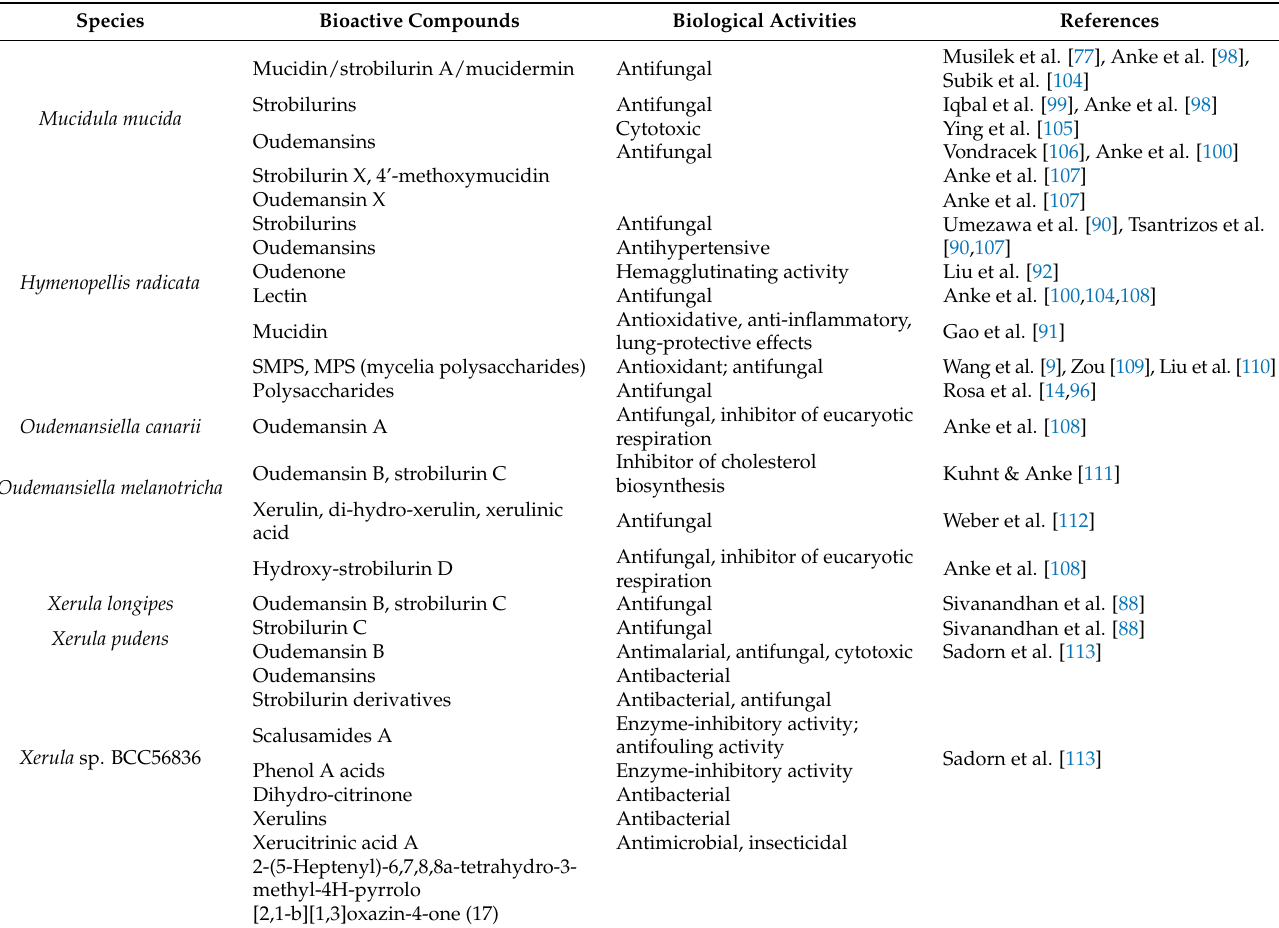
Table 3. Secondary metabolites produced by some species of the OX complex with their